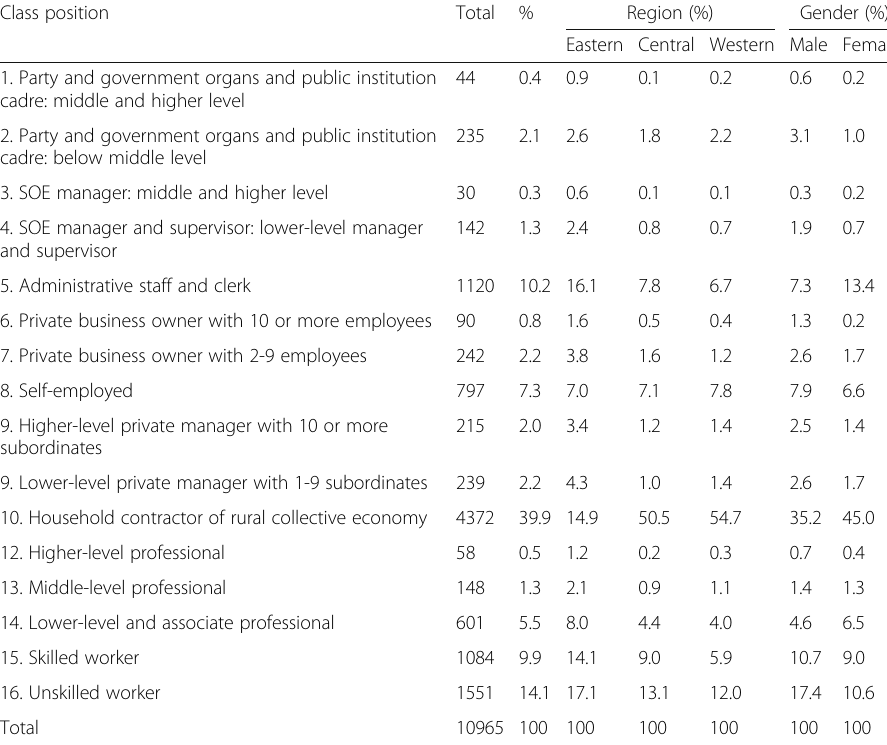
Table 5 Class positions in transitional China: 2010 CGSS Class position Total % Region (%) Gender (%)